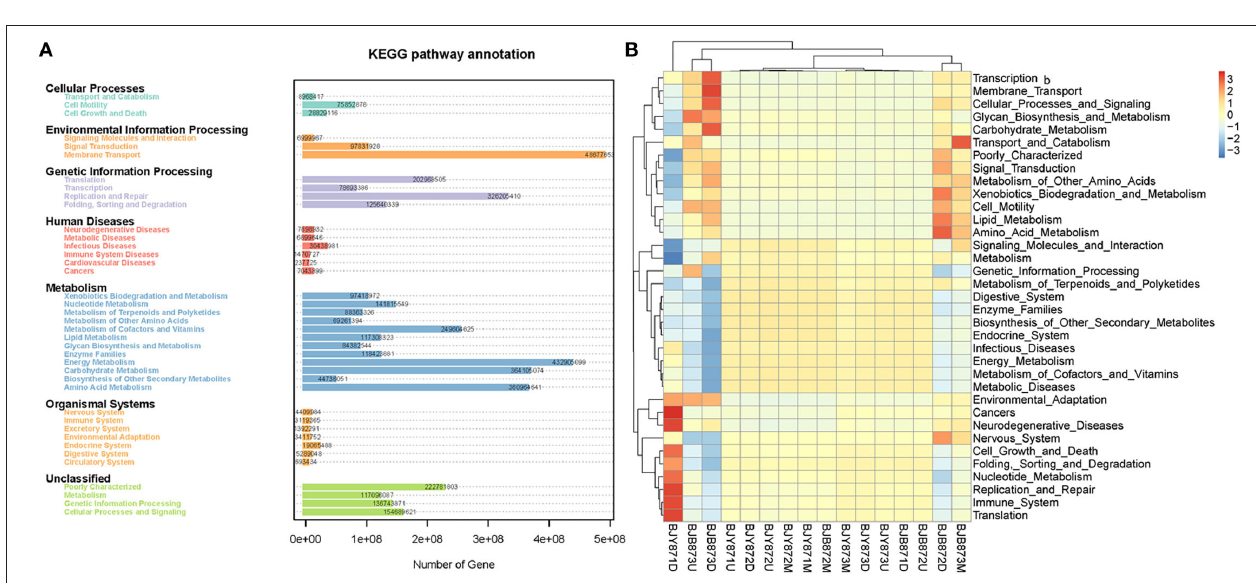
Pseudomonas were the dominant ones in 16 samples, respectively, coinciding with Zhang’s report (Zhang et al., 2020). The gene sequences in sixteen samples were mostly involved in the Pathotroph-saprotroph-symbiotroph and it was the main fungal trophic mode. The predominant pathway and sub-functions were metabolism function and membrane transport.